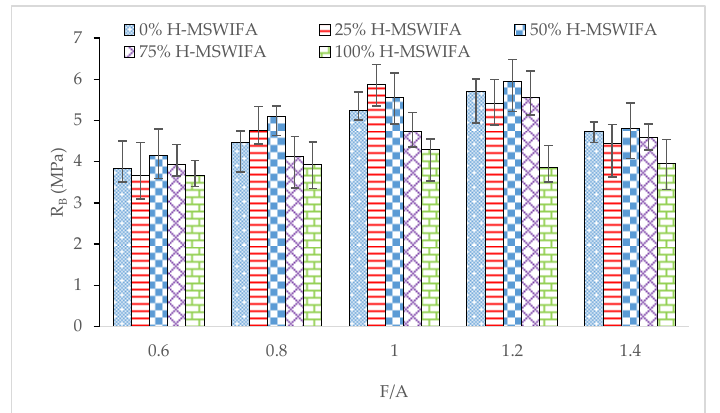
Figure 4. Test results of R B .